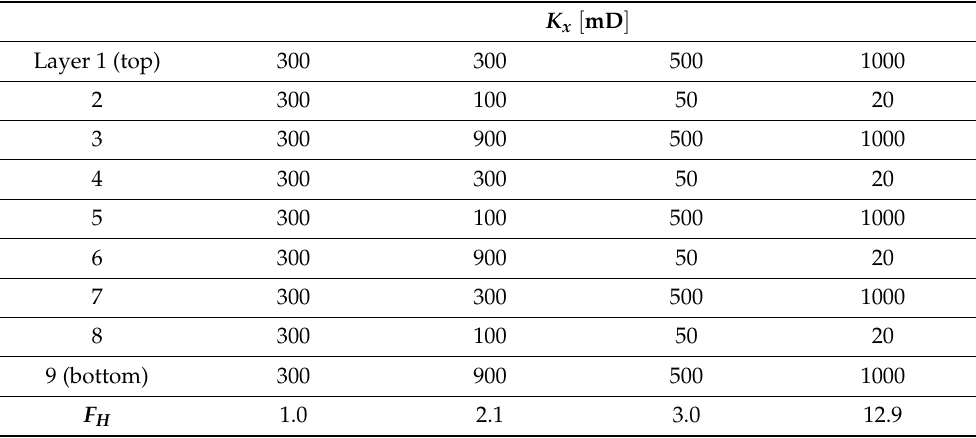
Table A3. Specification of model heterogeneities. Each model had 9 layers with permeability distributed as specified. It was assumed that vertical and horizontal permeabilities were equal in each layer: K z , j = K x , j